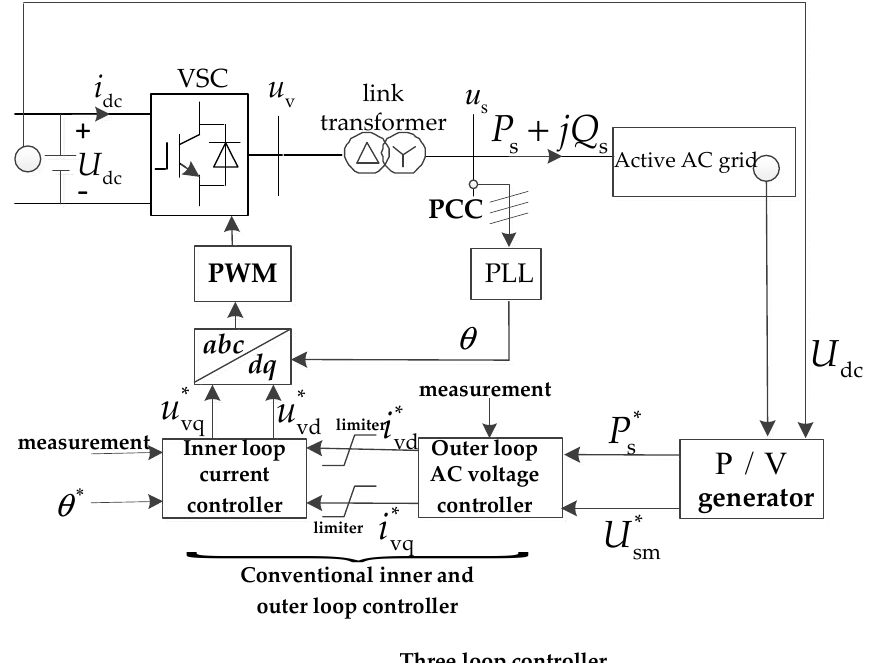
Figure 4. Three-loop controller diagram of the PV type grid-following nonsynchronous-machine